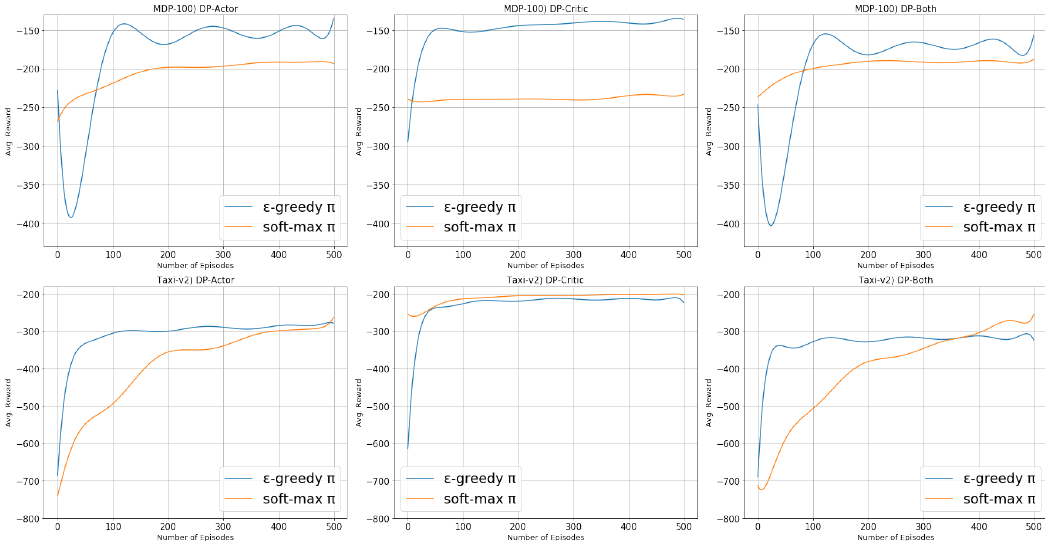
Figure 5. Learning curves by two different policies ( (cid:101) -greedy and soft-max). We select the best performing parameter sets in all of the parameter combinations after averaging rewards for each parameter set run over 10